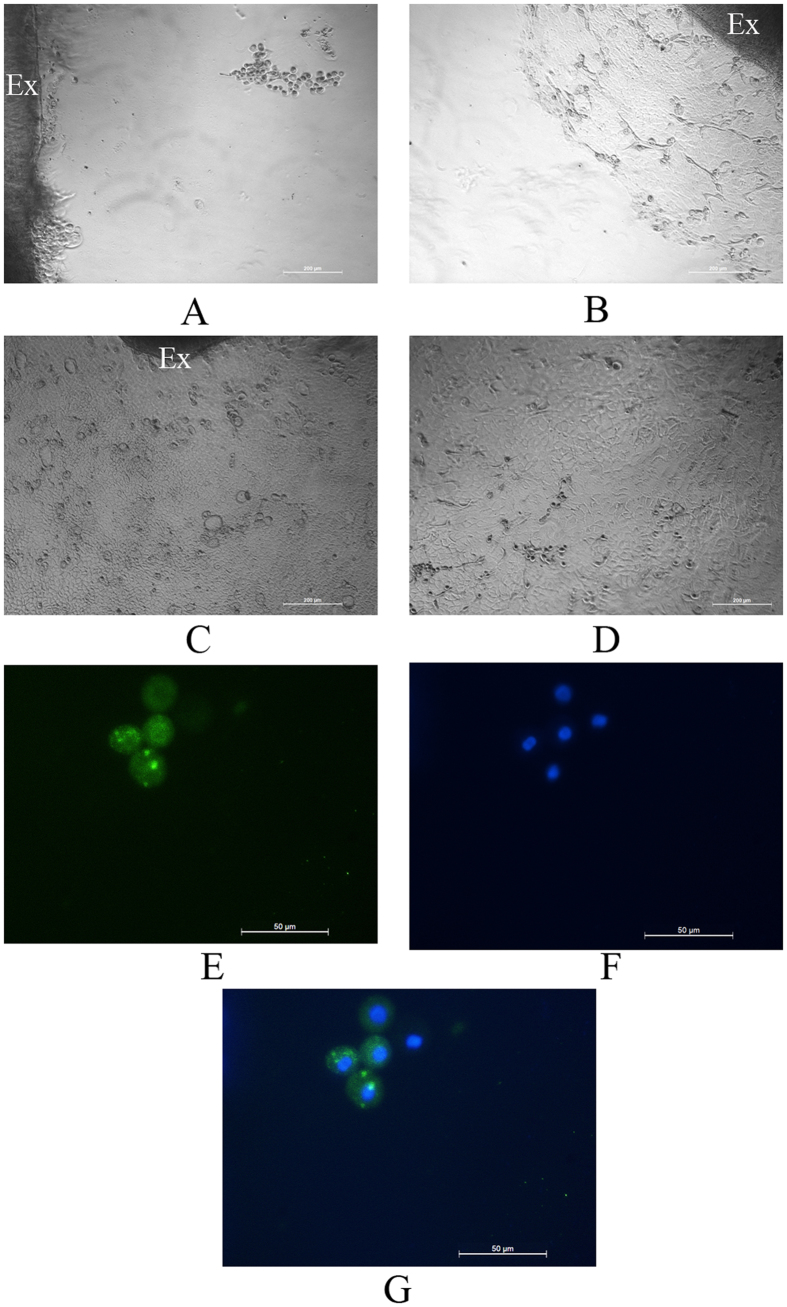
Effect of Am films on corneal epithelial cell growth and characteristics: Corneal explants (marked as Ex) were cultured on Am films, sprouting of epithelial cells were observed on day 4 (A), cellular outgrowth continued to occur and cells had grown further on day 6 (B) and gradually formed a cell sheet on day 10 with corneal epithelial cells displaying cobble stone appearance (C). Corneal epithelial cells cultured on culture discs also showed similar phenotype (D). Immunocytochemistry showed expression of cytokeratin3 by the cells (E), nuclei stained with DAPI (F) and merged image (G).